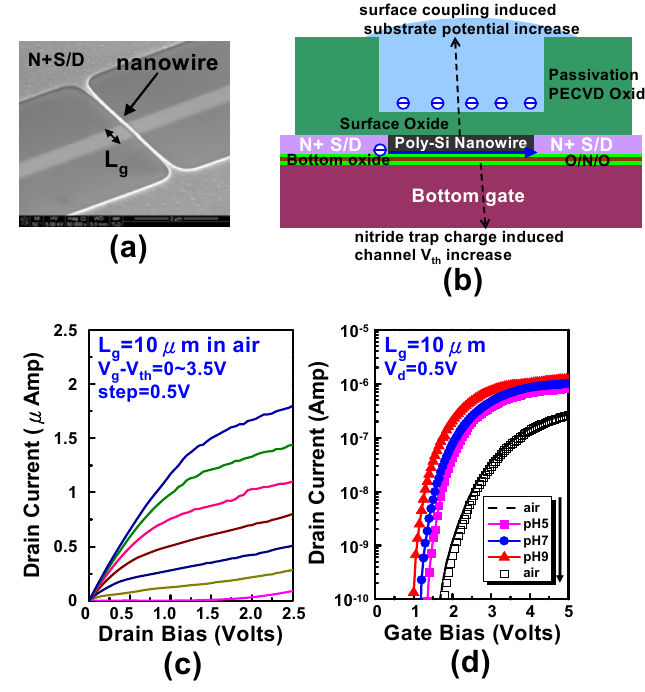
Figure 2. ( a ) Top-View SEM image of the poly-Si nanowire FETs; ( b ) Schematic representation of the bottom gate poly-Si nanowire FETs cross-sectioned with pH solution; -V output characteristics of the poly-Si nanowire FET device measured in air; ( c ) I d d ( d ) I -V characteristics of the poly-Si nanowire FETs measured in air/aqueous pH solution. d g The pH testing operation did not degrade the electrical characteristics of the